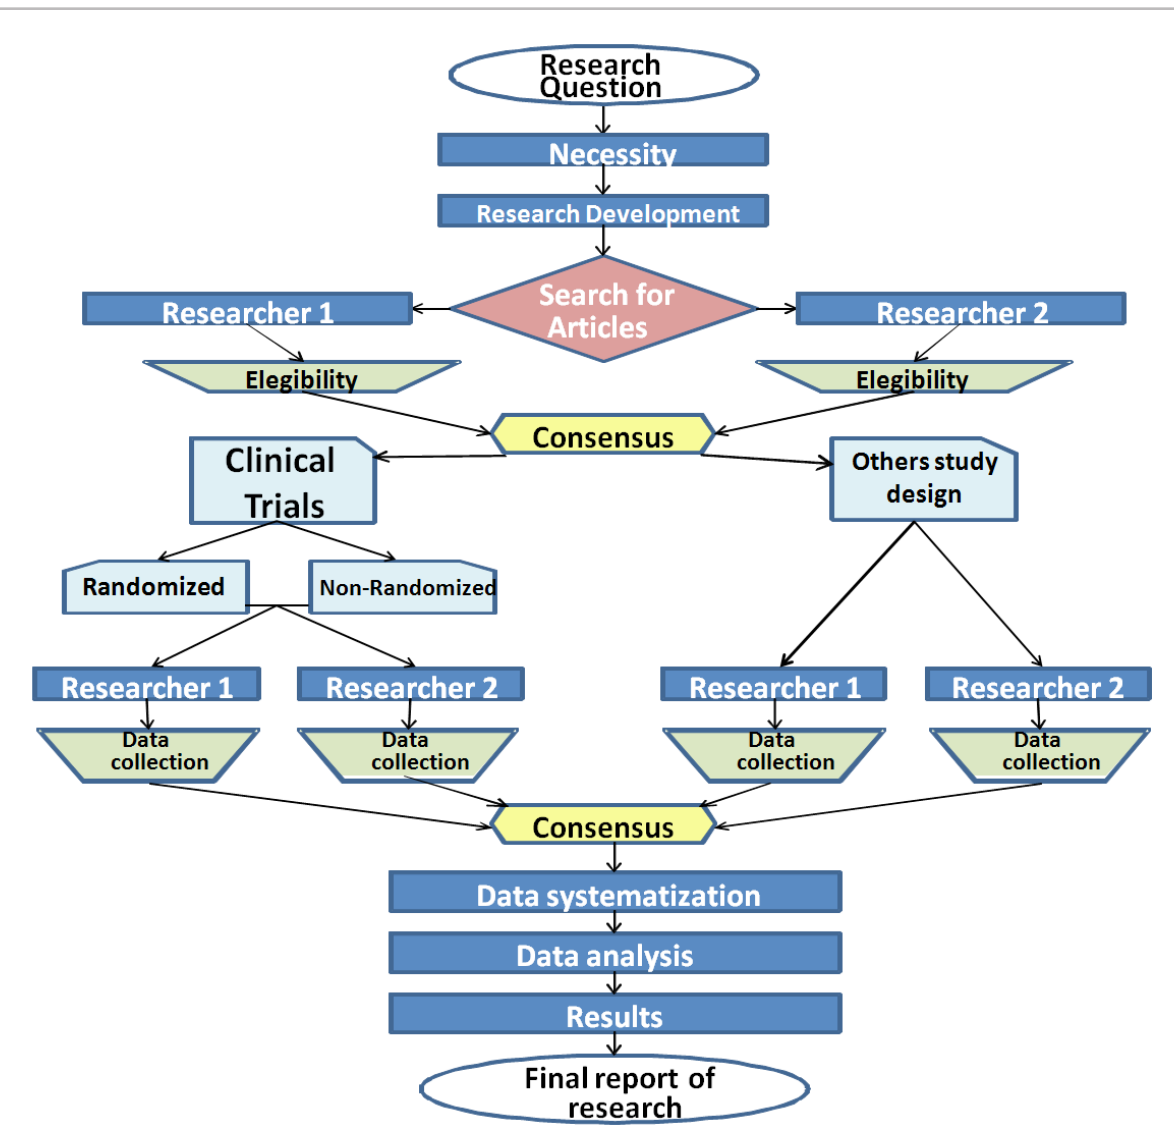
FIGURE 1 - Systematic review